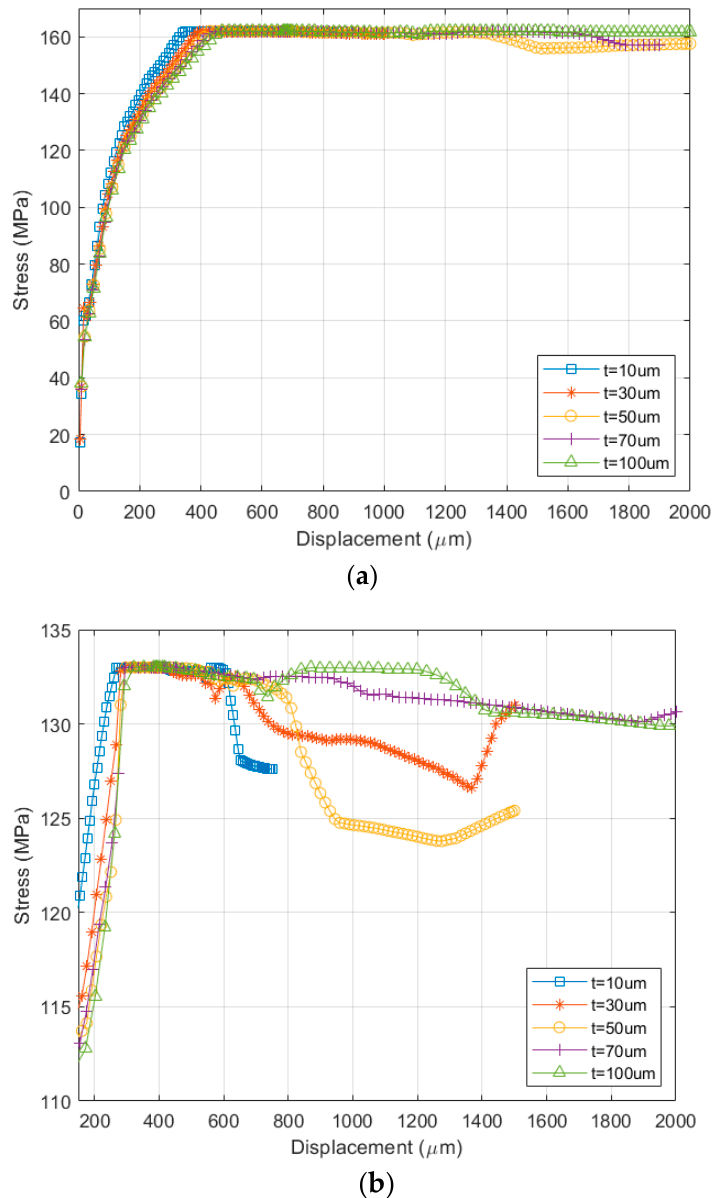
Figure 9. Stress-strain curves depending on the sample thickness. ( a ) FPCB. ( b ) PSPI.